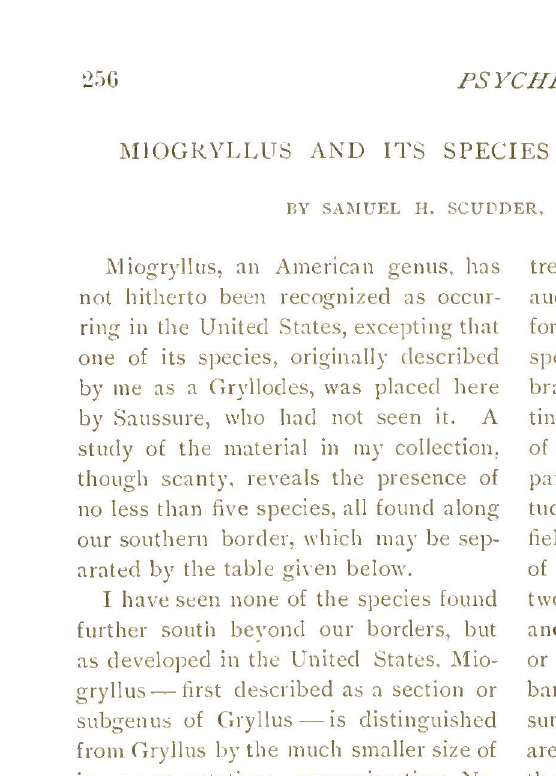
Table of lite U11ited States species of